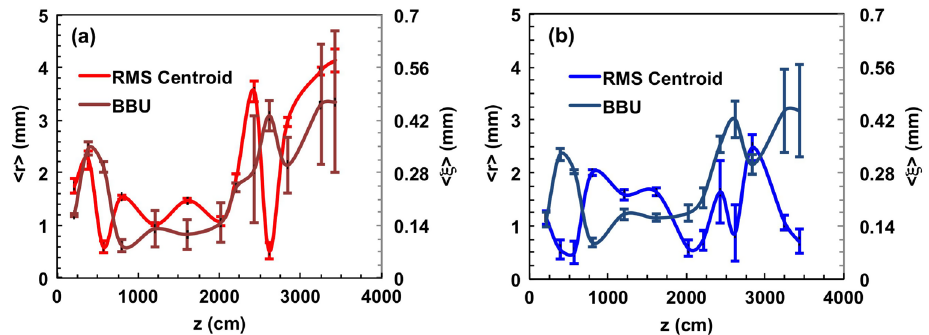
FIG. 12. Measured rms centroid offsets h r i , and the radial BBU amplitude, h ξ i , averaged over five shots along the length of the accelerator for the (a) misaligned case (red and dark red) and (b) aligned case (blue and navy blue). Note reduction from (a) to